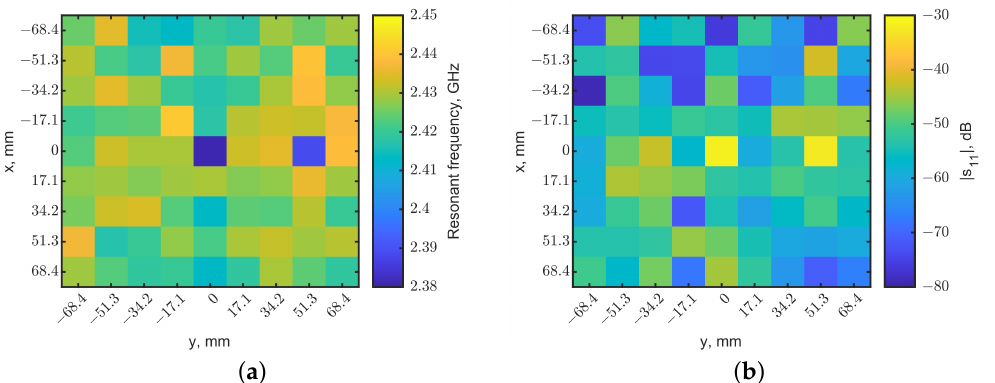
Figure 10. Heatmaps generated from reflection coefficients for two tumors at a depth = 10 mm. The tumors were located at (x, y) = (0, 0) and (0, 51.3). ( a ) Map of resonant frequencies; the dark-blue pixel indicates the tumor’s location. ( b ) Map of |s 11 |, the light-yellow pixel indicates the tumor’s